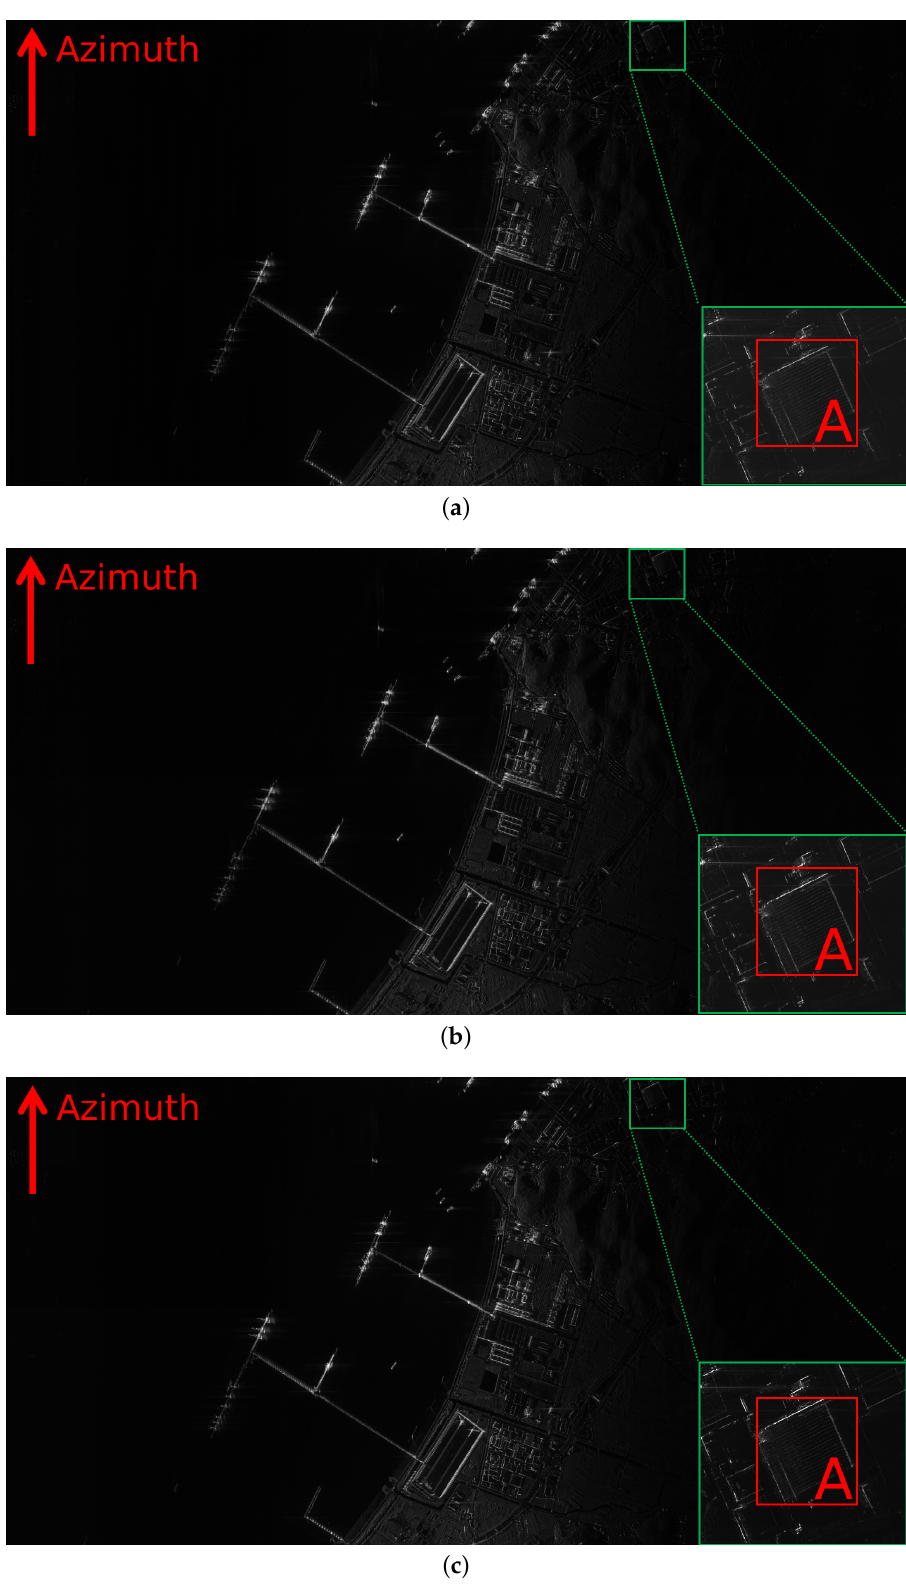
Figure 17. Experimental results of the 3.6 GHz-bandwidth SAR data. (Provided by the IECAS) ( a ) Complete image focused with TSM MoCo scheme. ( b ) Complete image focused with traditional OSM MoCo scheme. ( c ) Complete image focused with the proposed MoCo